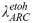
Sensitivity of ethanol production on the PhPP of S. cerevisiae.
λARCetoh: Sensitivity of qetoh to the Available Reducing Capacity (ARC). Planes are colored according to λARCetoh value, indicating if ARC is limiting (λARCetoh<0), is in excess (λARCetoh>0) or it has no effect on qetoh. (a) showing the PhPP for specific growth rate (μ). (b) showing PhPP for specific ethanol productivity (qetoh).